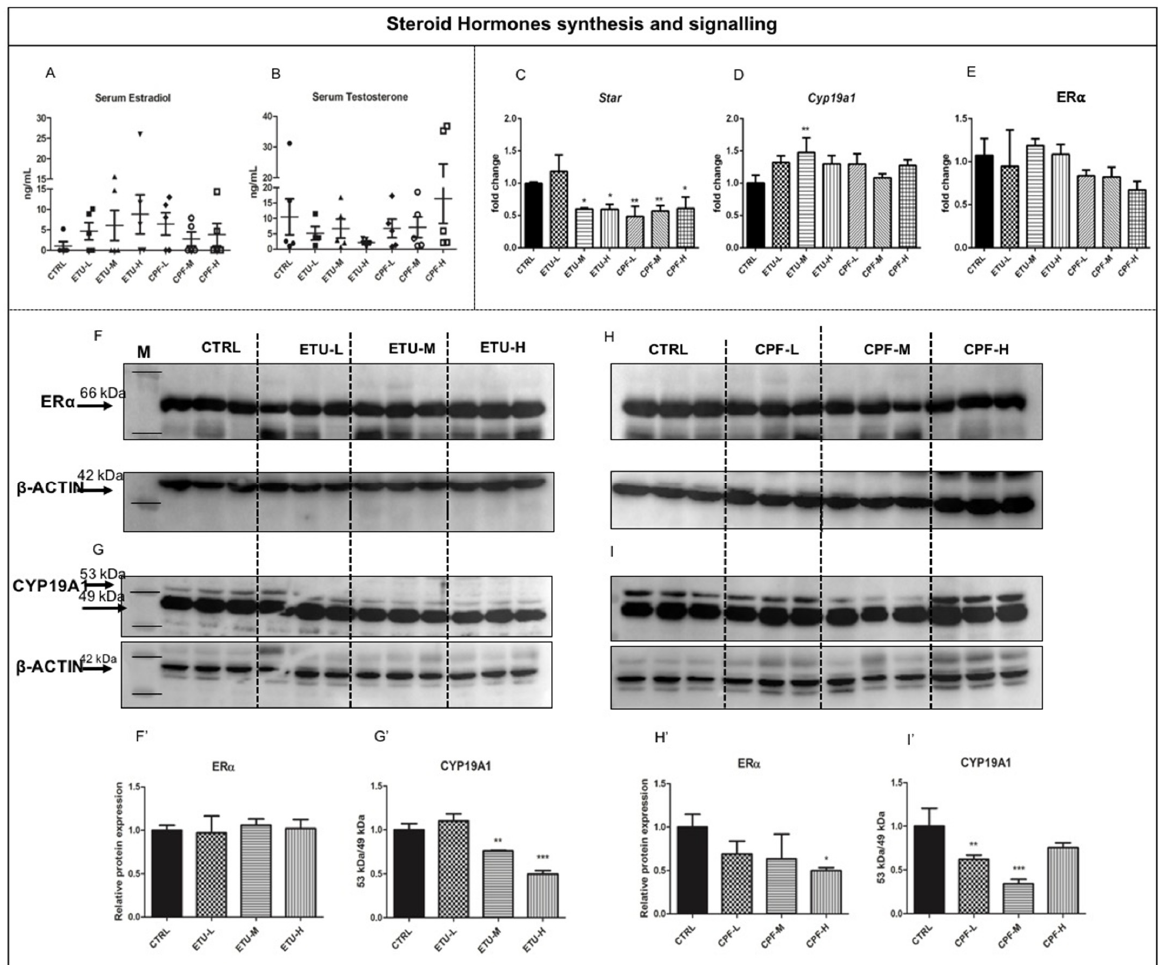
Figure 1. Developmental exposure to different dose of ETU and CPF effects steroid hormones biosynthesis and E2 signaling in mouse testis. ( A , B ) Serum free testosterone and 17- β estradiol levels were detected by GC/MS assay in mouse exposed to pesticides. ( C – E ) Levels of Star , Cyp19a1 , and Er α transcript assessed by RT-qPCR analysis, performed on three biological samples ( n = 3 testis/group). Data are reported as fold change values calculated as a ratio between average relative gene expression in treated and control testes, after normalization on β -actin mRNA. Mean and standard deviation are reported. ( F , F’ , G , G’ ) Western blot analysis showing the levels of ER α and CYP19A1 proteins following ETU treatment. Three mice were analyzed within the same group. Two isoforms were detected for CYP19A1 of 53kDa and 49kDa. Normalization was done detecting B-ACTIN. ( H , H’ , I , I’ ) Western blot analysis showing the levels of ER α and CYP19A1 proteins following CPF treatment, conducted as described above. Data analysis was conducted as described in M&M. One-way ANOVA (post hoc test: Dunnett’s) was used. * p < 0.05, ** p < 0.01, *** p <